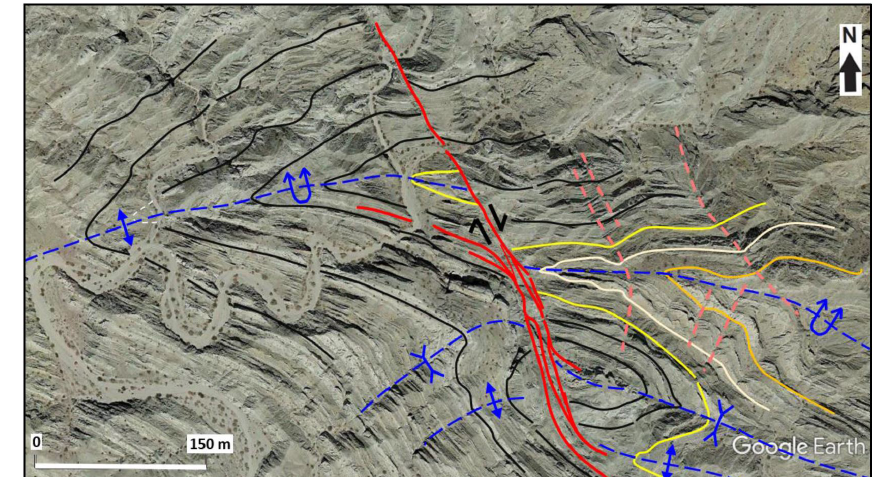
Figure 6. Interpreted satellite image of the central macro-fold showing right-lateral offset of the entire fold hinge/axial surface (upper left dashed blue line) by a NNW–SSE-trending, NE-dipping strike-slip fault (red lines). Note that the fault merges out from a layer in the southern limb of the macro-fold (black lines) and continues as a right-lateral fault. Offset geological markers include thick sandstone beds (yellow, white, light brown lines) and the fold axial surfaces of a second syncline fold farther south (lower right, dashed blue lines). Note that the syncline axial trace dies out to the southwest and that kink bands acting as cross faults crop out in the eastern part of image (dashed pink lines). Uninterpreted version of the image available as Fig. S8. © Google Earth